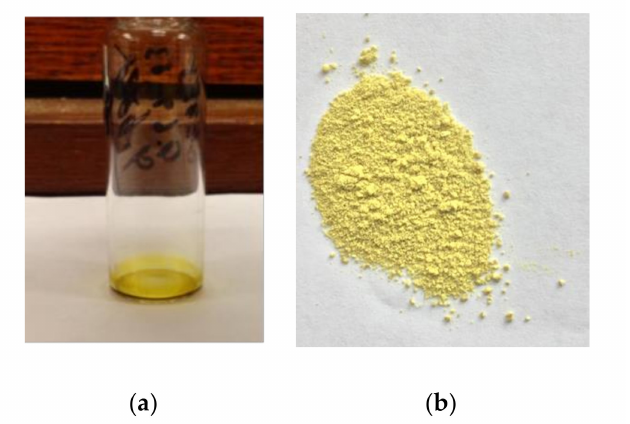
Figure 1. Lemon-derived yellow #15 in aqueous solution ( a ), and in powder form ( b ) (pictures by Dr. X. Chen and Prof. M.T. Hamann, The Medical University of South Carolina).